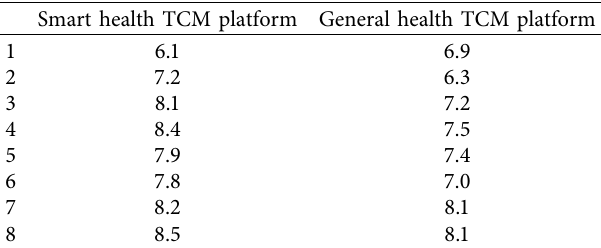
Table 1: Satisfaction scores of the two